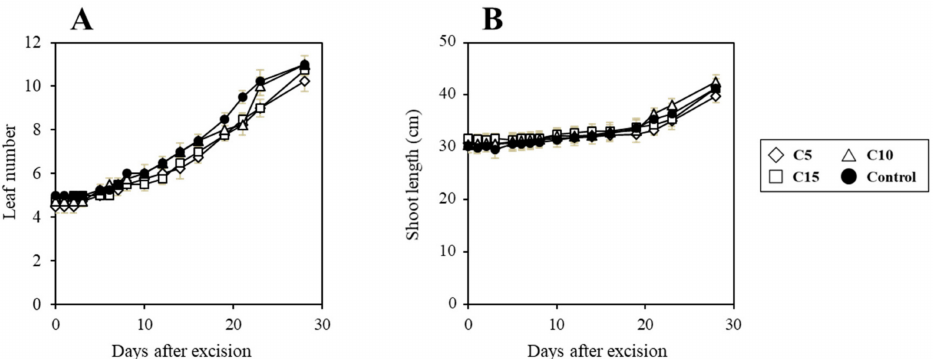
Figure 2. Time course changes in leaf number ( A ) and shoot length ( B ) of carrots after partial taproot excision. Vertical bars represent ± SE ( n = 4).